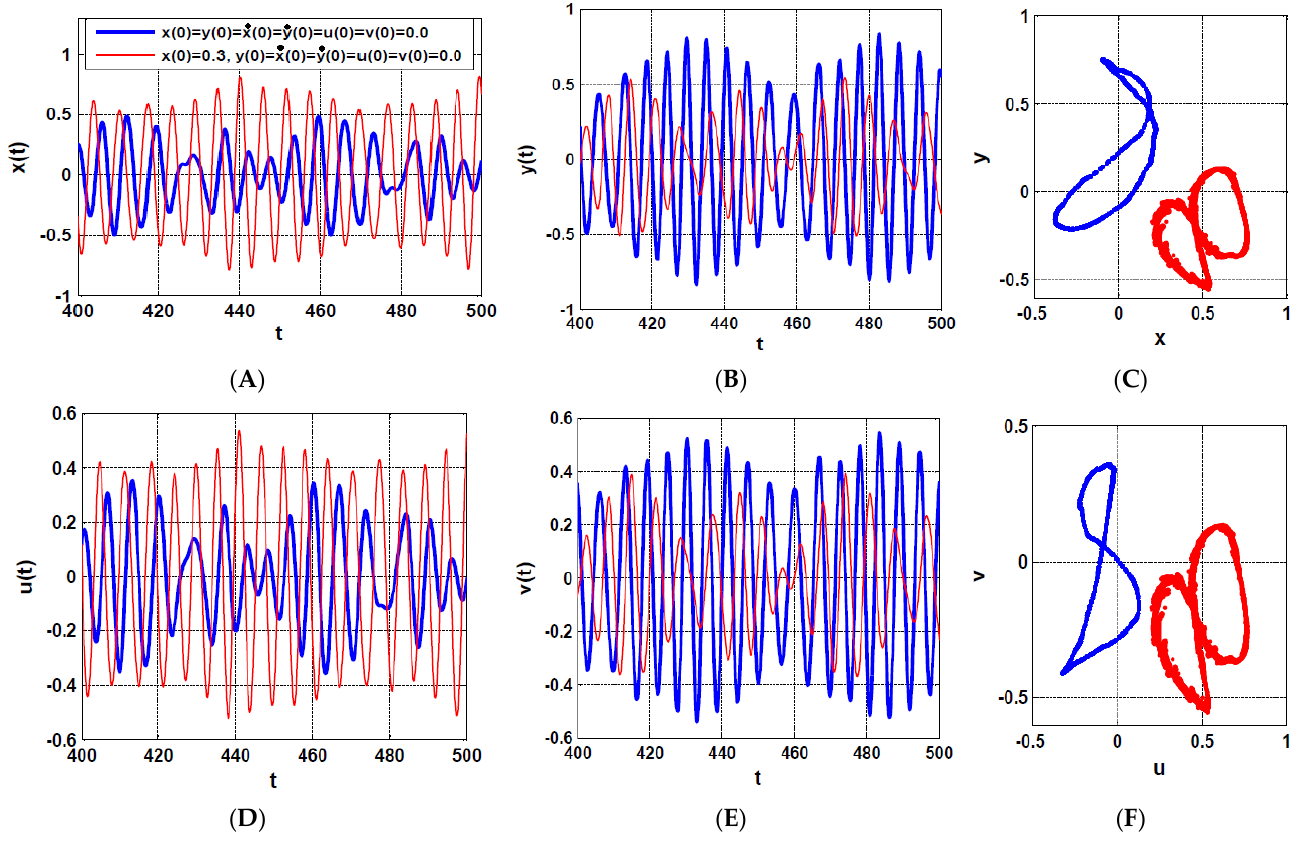
Figure 11. The rotor system steady-state time-response according to the point p 1 shown in Figure 10B (i.e., when 𝑓 = 0.075 , 𝜂 1 𝜂 3 = 0.05, 𝜂 2 𝜂 4 = 0 ): ( A – C ) temporal oscillation in 𝑋 and 𝑌 directions and the corresponding Poincaré map, respectively, ( D – F ) temporal oscillations of the U-IRC and V-IRC and the corresponding Poincaré map, respectively.